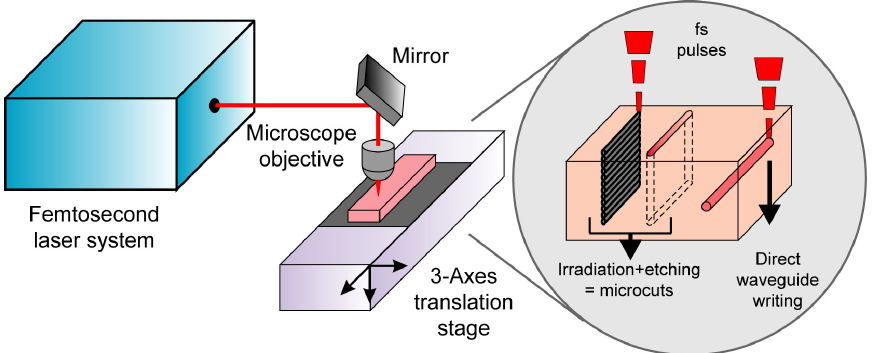
Figure 2. Schematic set-up for femtosecond laser micromachining. Multilevel irradiation followed by selective chemical etching is used to perform microcuts through the whole sample thickness. Direct waveguide writing can also be performed by using a lower intensity